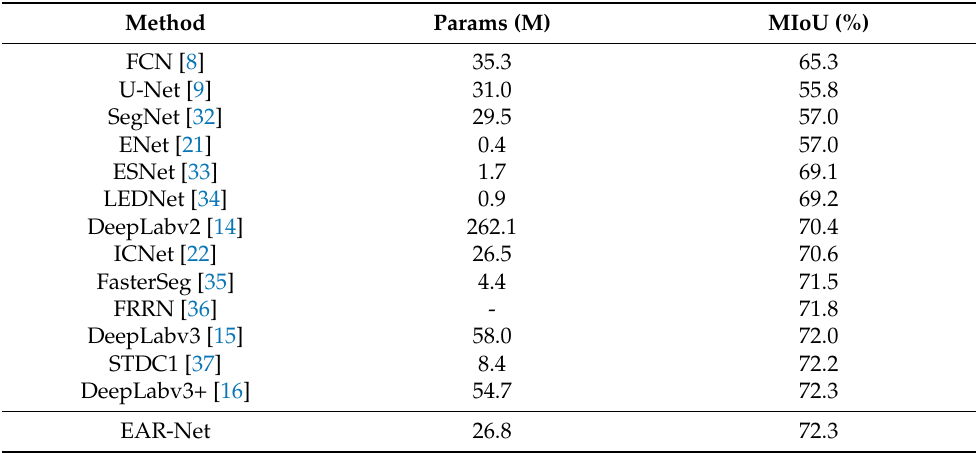
Table 2. The results on Cityscapes dataset. “-” means the result is unavailable.